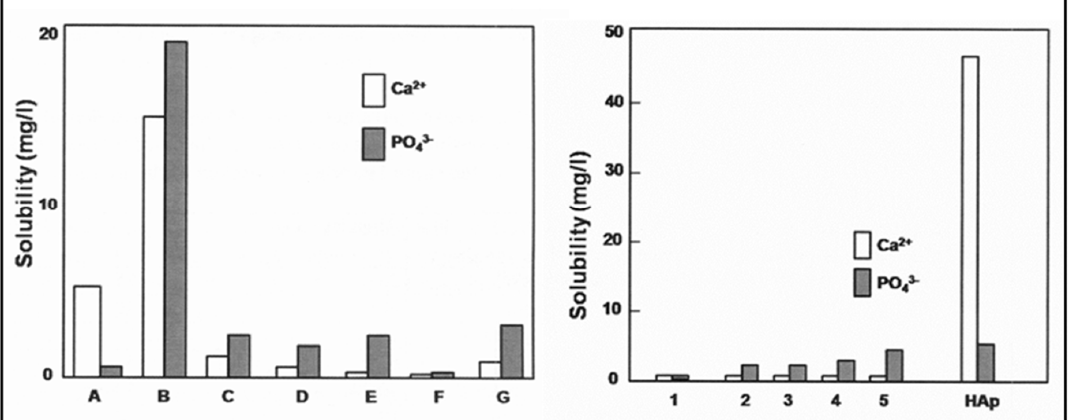
Figure 2. Left: Solubility of Ca(Ti,Zr) hexaorthophosphate powder compacts in 0.2 molar tris–hydroxymethyl–amino–methane–HCl (TRIS–HCl) at pH = 7.4 and 37 °C [16]. A Hydroxylapatite, B α –tricalcium phosphate, C CaTi 4 (PO 4 ) 6 , D CaTi 3 Zr(PO 4 ) 6 , E CaTi 2 Zr 2 (PO 4 ) 6 , F CaTiZr 3 (PO 4 ) 6 , G CaZr 4 (PO 4 ) 6 . Right: Solubility of atmospheric plasma-sprayed CaTiZr 3 (PO 4 ) 6 coatings in